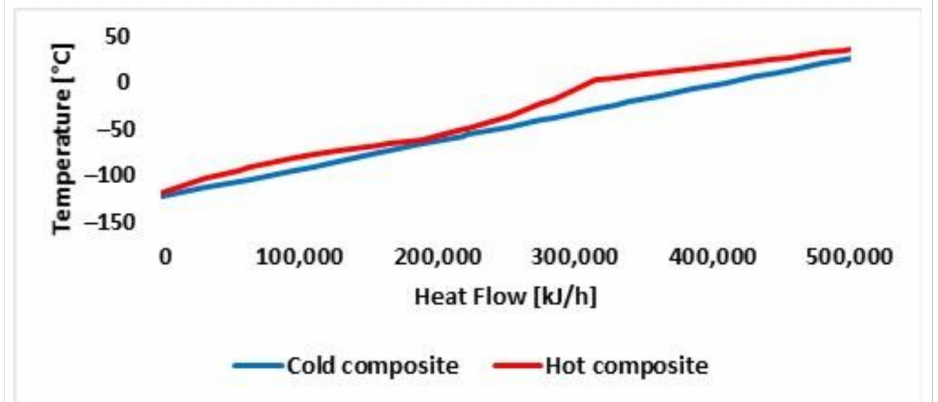
Figure 11. Heat transfer composite curves for Base Case Cold-Box.